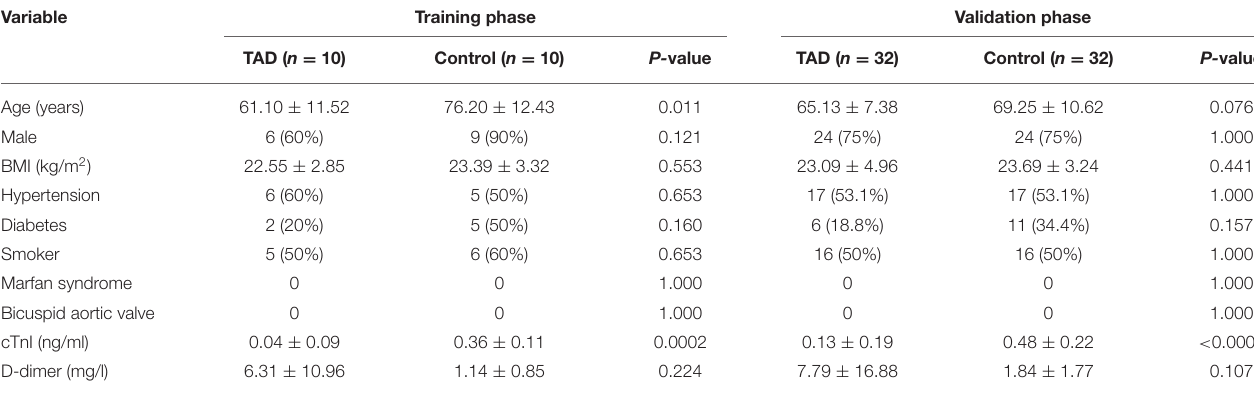
TABLE 2 | Characteristics of the TAD group and control group in the training phase and validation phase.